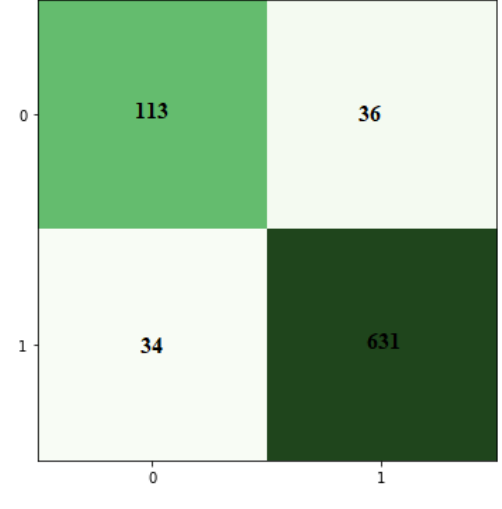
Figure 5. Random Forest Confusion Matrix